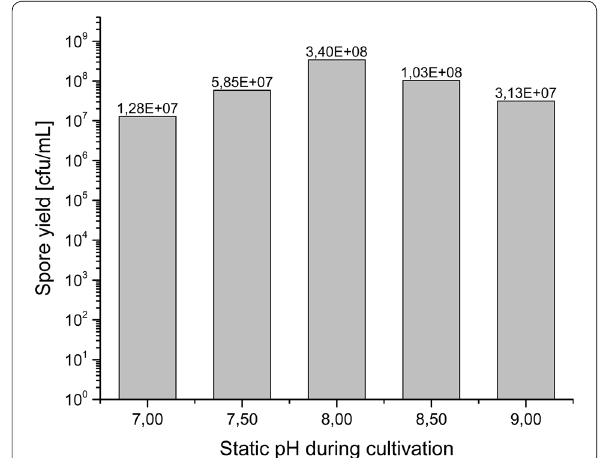
Fig. 1 Spore yield shown as colony forming units (cfu) per mL